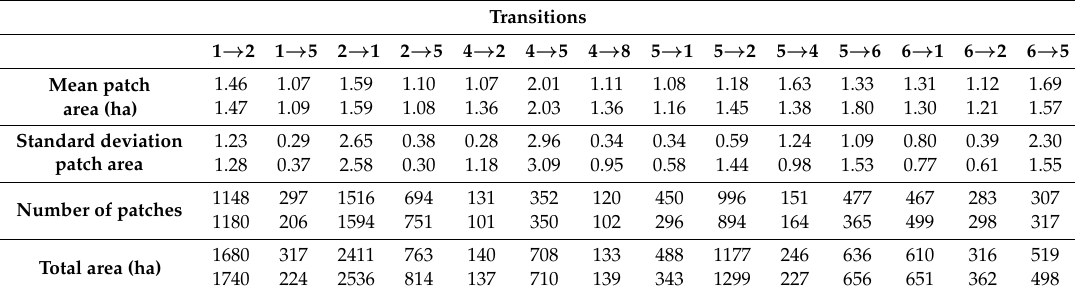
Table 5. Sample of the transitions modelled for VD_R2. Geometric and quantity comparison between 1997 and the real dataset for 2009, and between the real 1997 and the modelled 2009 dataset. The calibrated model gives similar patches geometries in comparison to the observed one, although we observe some variations concerning the standard